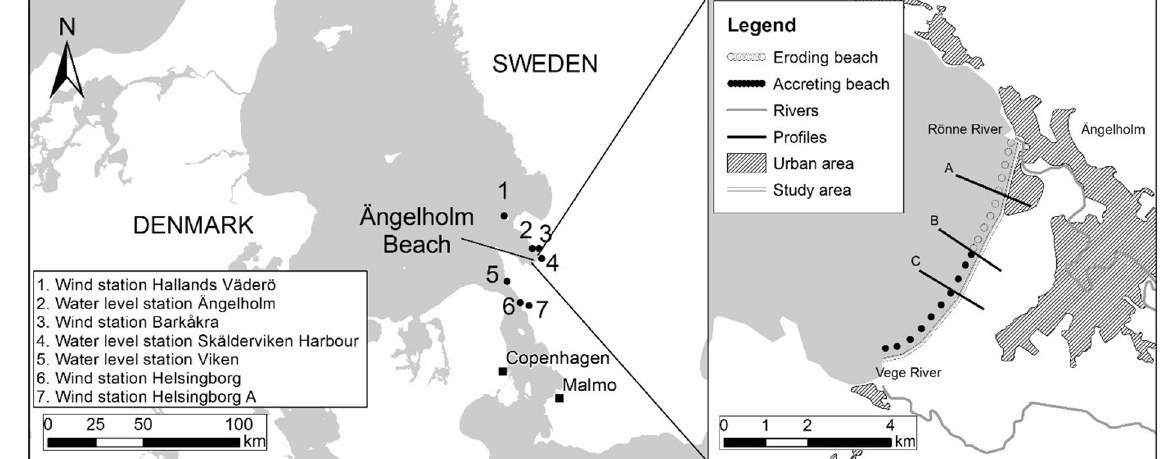
Fig 6. Maps over the study area and measurement